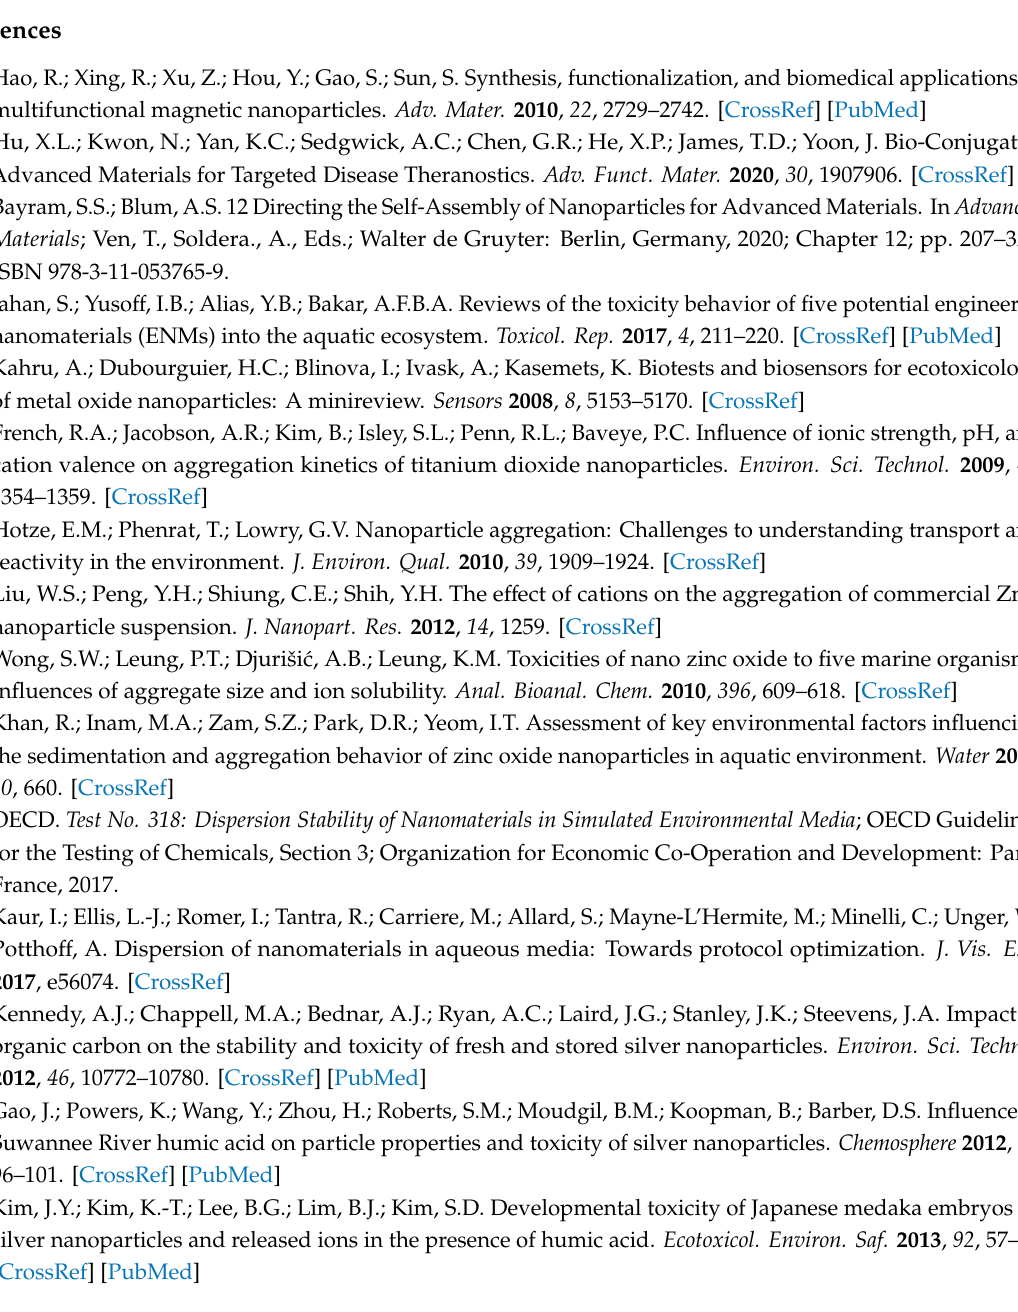
Figure S1: Comparison of algae growth inhibition by ZnO depending on the NOM, Table S1: Zeta potential and pH changes of test medium with ZnO with / without